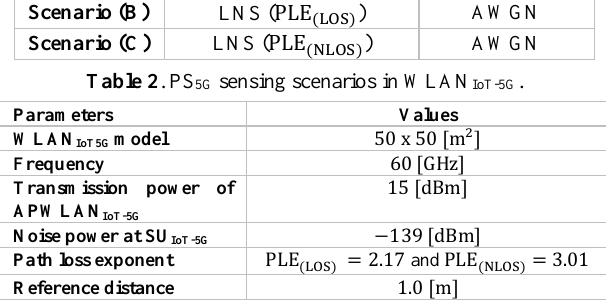
Table 3 . Simulation parameters.